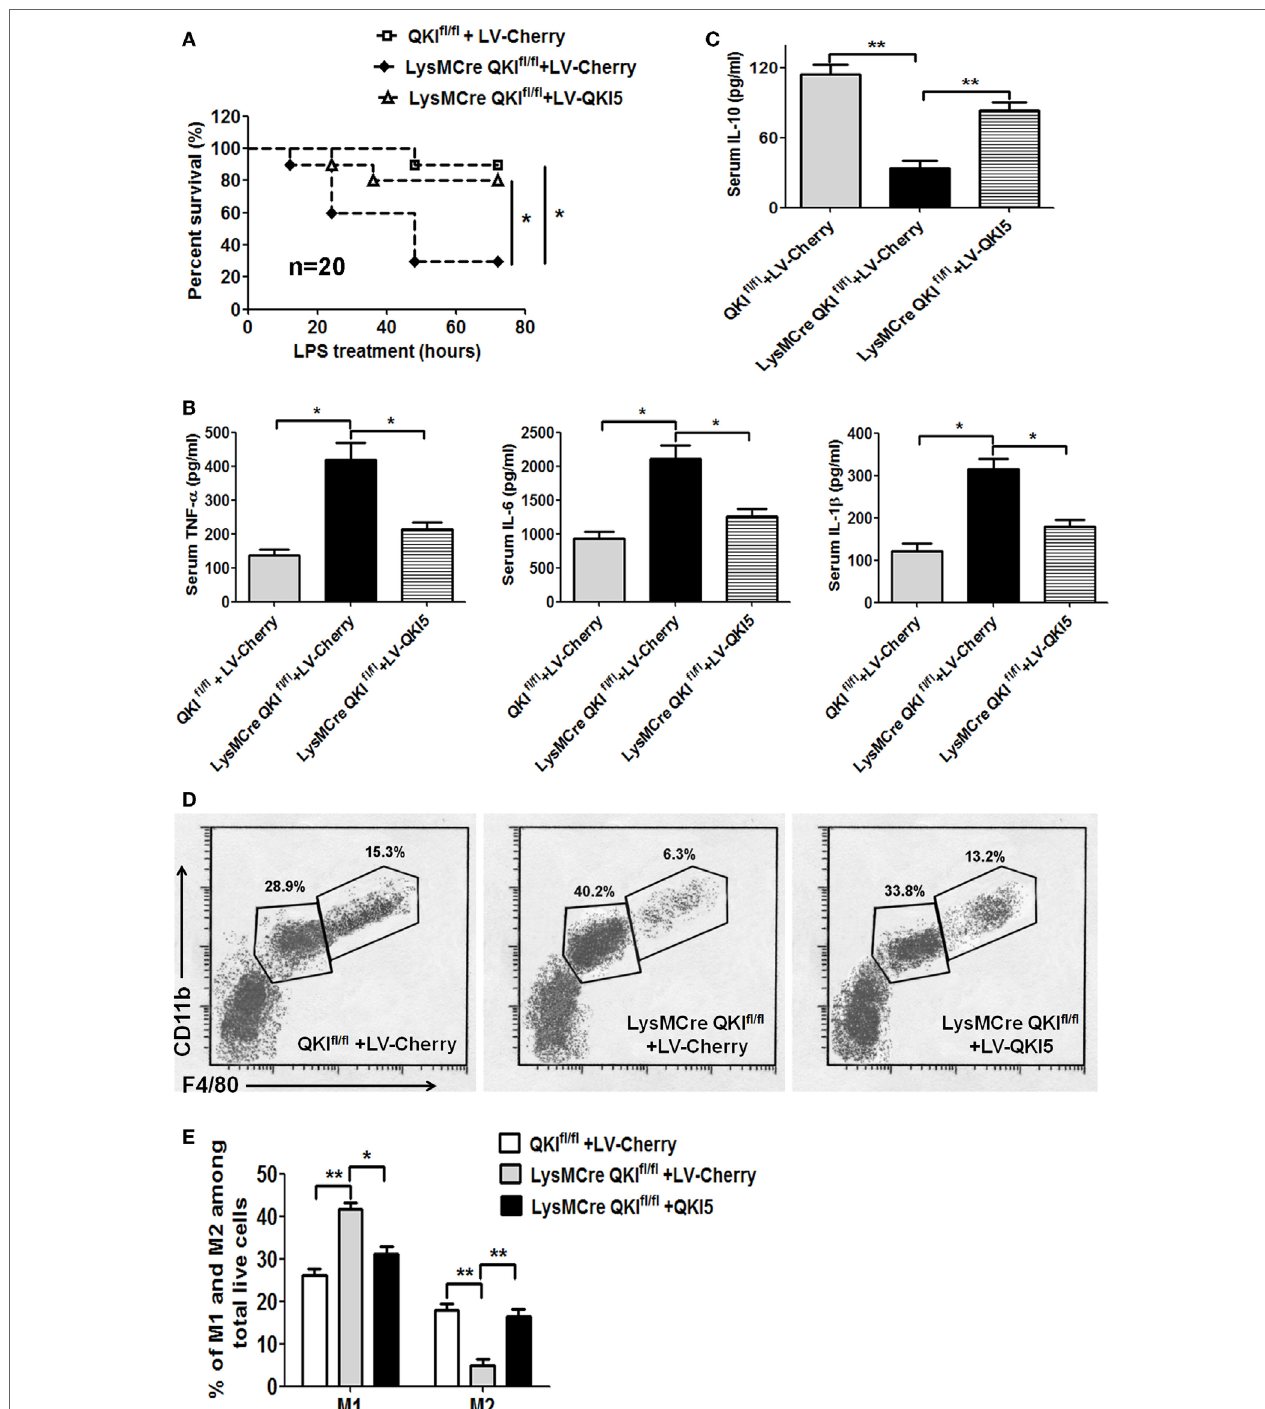
FigUre 7 | Transfer of peritoneal macrophages overexpressing QKI5 rescued lipopolysaccharide (LPS)-induced endotoxic shock. (a) Peritoneal macrophages overexpressing QKI5 (2 × 10 6 /mouse) or control cells (LV-Cherry) were intraperitoneally injected 0.5 h after QKI fl/fl and LysMCre QKI fl/fl mice were challenged with LPS (40 mg/kg). Survival was observed. The data shown are pooled from the two independent experiments ( n = 20). (B,c) Serum samples were collected 4 h after LPS injection. Inflammatory cytokines TNF- α , IL-6, IL-1 β (B) , and IL-10 (c) were analyzed using the Dakawe mouse enzyme-linked immunosorbent assay (ELISA) assay kit. (D) Twenty-four hours after LPS challenge, mouse peritoneal cells were collected and analyzed by flow cytometry to discriminate macrophage subtypes. F4/80 high CD11b high (M2) and F4/80 int CD11b int (M1) gated out of total live cells. (e) Quantification of M1 and M2 cells in (D) obtained from LPS-challenged mice. All animal experiments were performed twice, independently and each time 10 mice/group were used in (a–c) . n = 20. For (D) , 6–9 mice/group were used. Data are presented as mean ± SEM. * p < 0.05, ** p < 0.01, *** p <